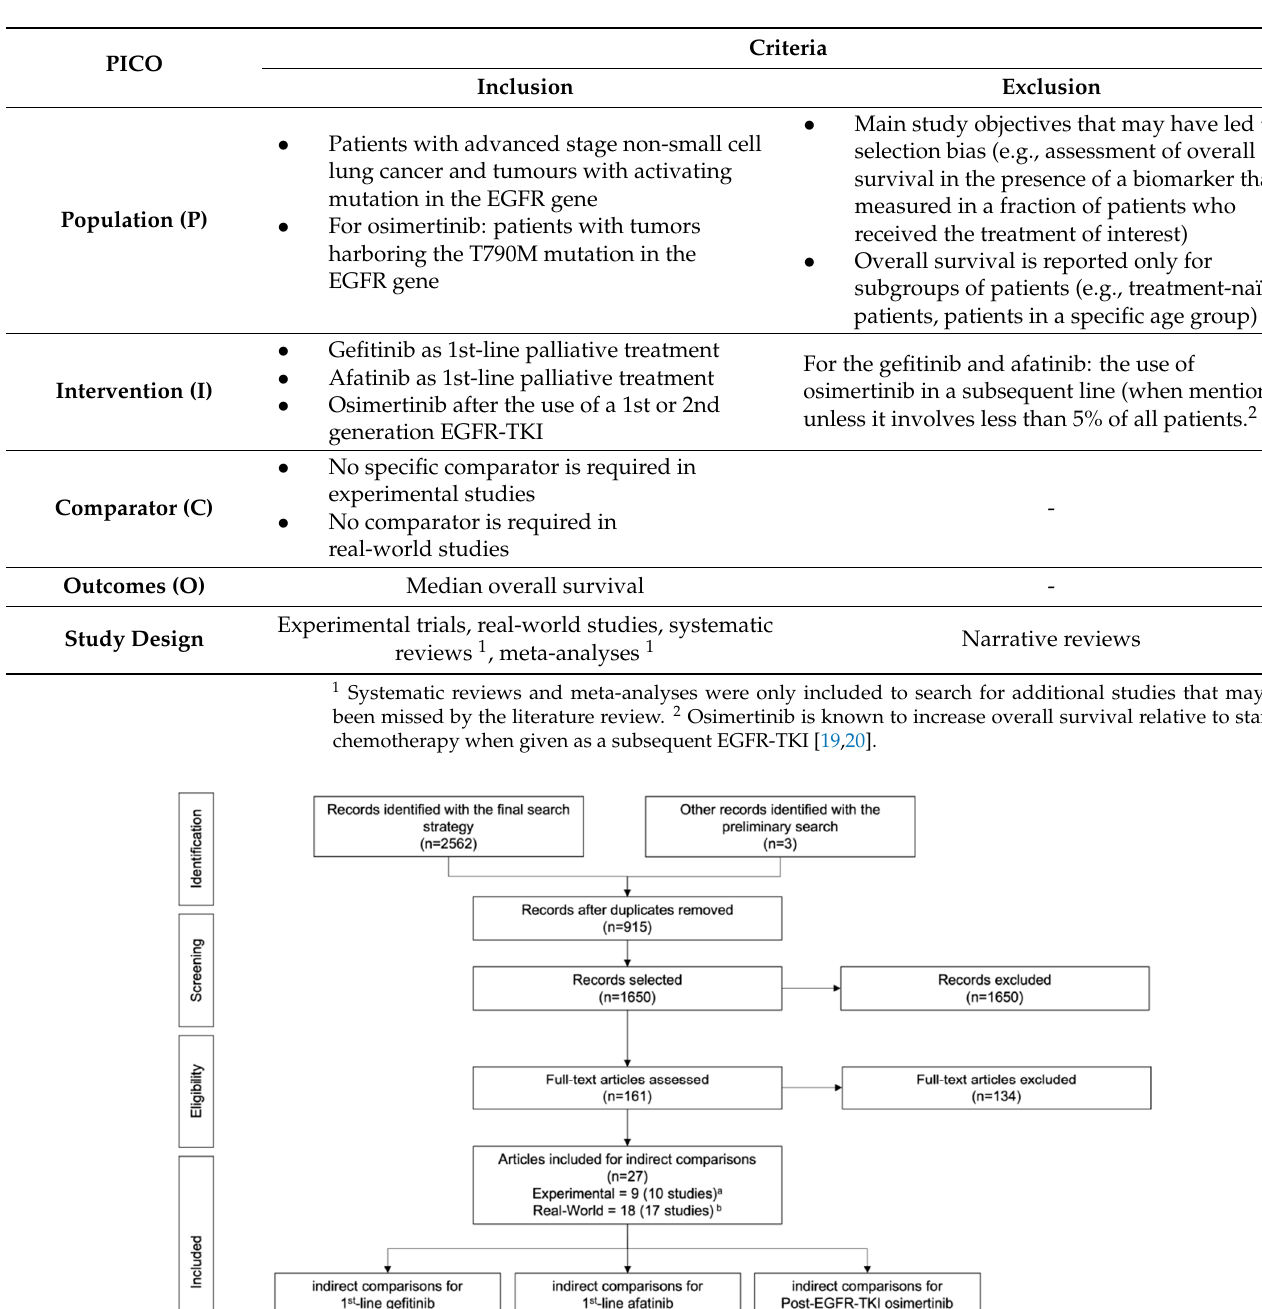
Table A5. Inclusion and Exclusion Criteria.